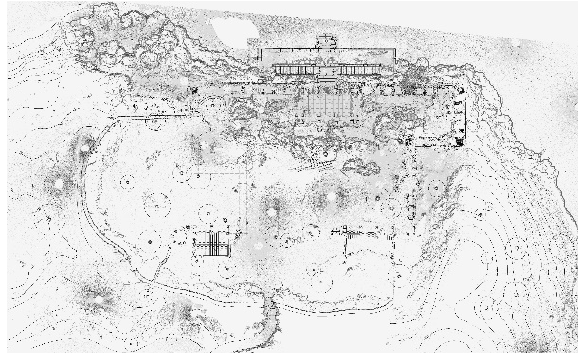
Figure 7. Current Situation Plane of Qiwang Hall